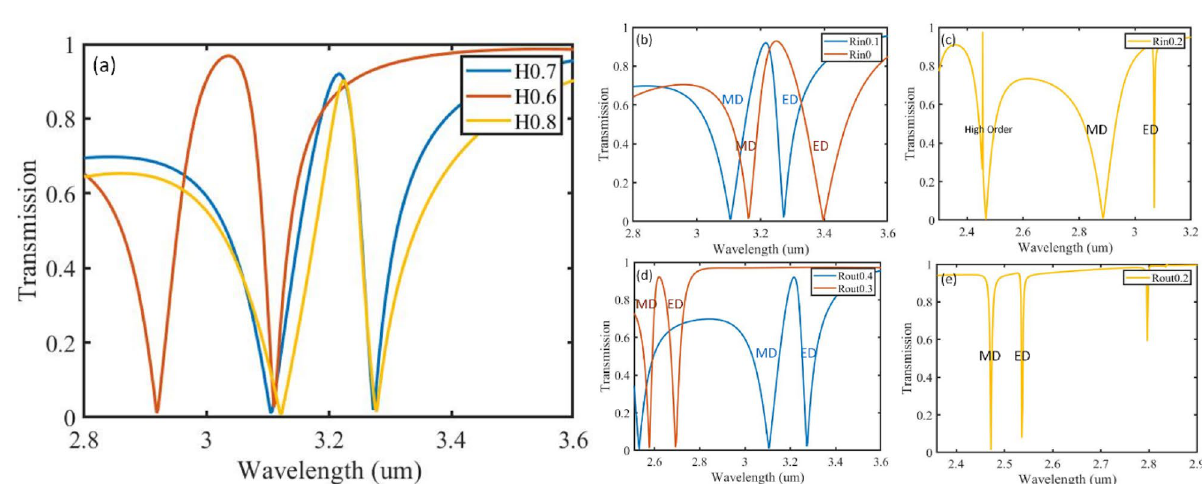
Figure 4. Transmission spectra of BPCs of ( a ) heights 0.6, 0.7, 0.8 µm ( b , c ) constant outer radius of 0. µmand inner radii of 0, 0.1, 0.2 µm ( d , e ) constant inner radius of 0.1 µm and outer radii of 0.4, 0.3, 0.2